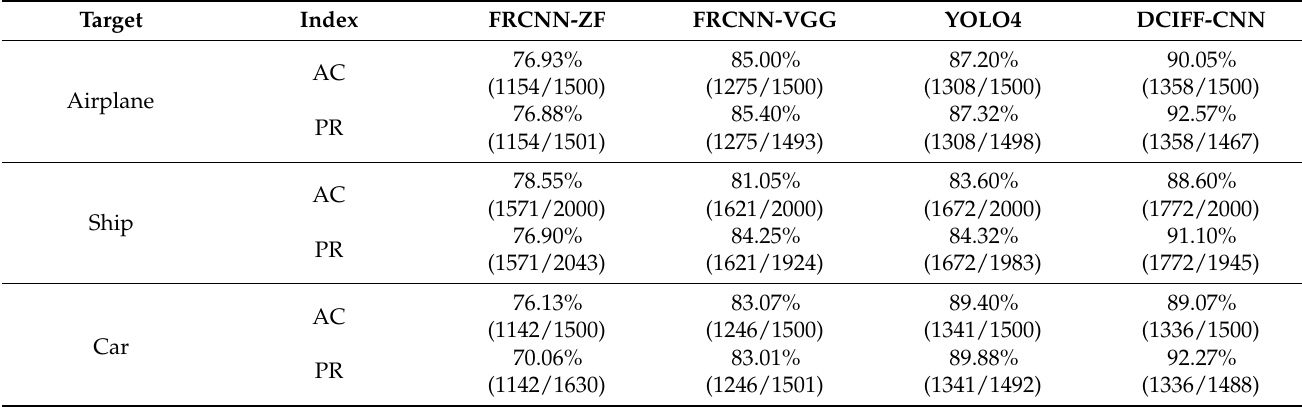
Table 4. Performance comparisons of various methods on the collected dataset.